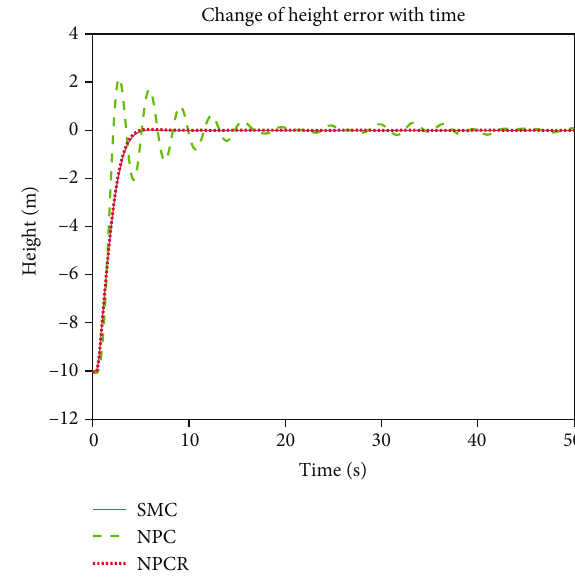
Figure 12: Height error changes with time under di ff erent controllers.